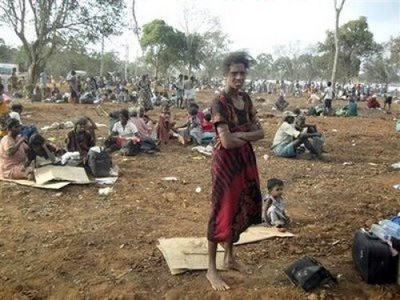
Utter Devastation [88].